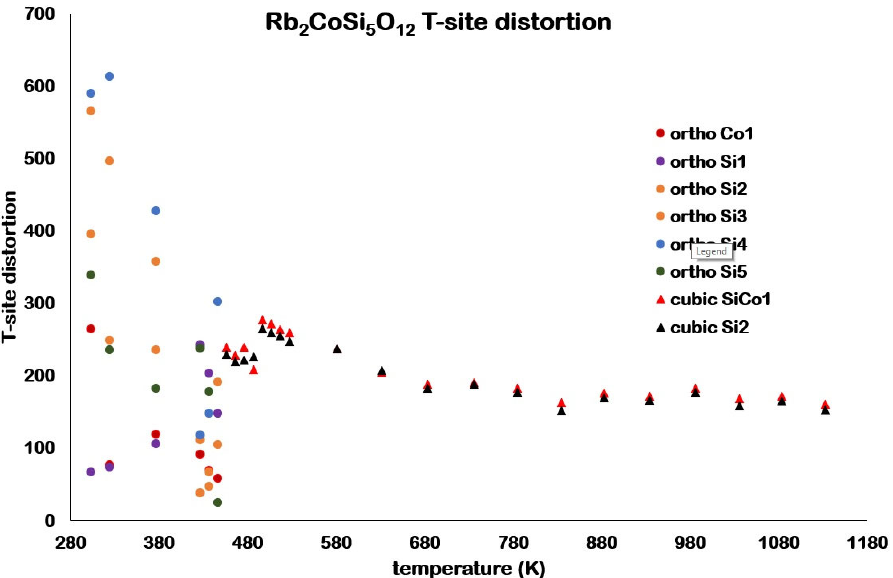
Figure 9. Variation of T-site distortion parameters with temperature showing how these parameters vary for the structures of Pbca orthorhombic and 𝑃𝑎 3 cubic Rb 2 CoSi 5 O l2 .